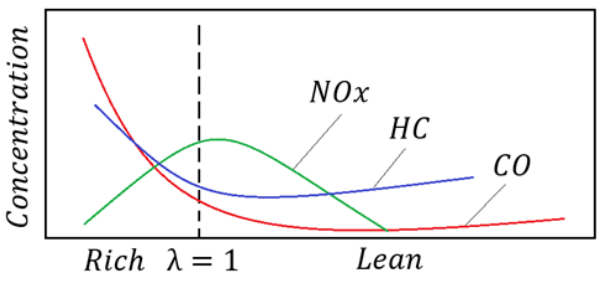
Fig. 1. Example of the effect of the air variation delivered to the combus- tion zone on the formation of nitrogen oxides (NO x ) and other atmospheric pollutants (on the example of the petrol combustion) (basing on [2])